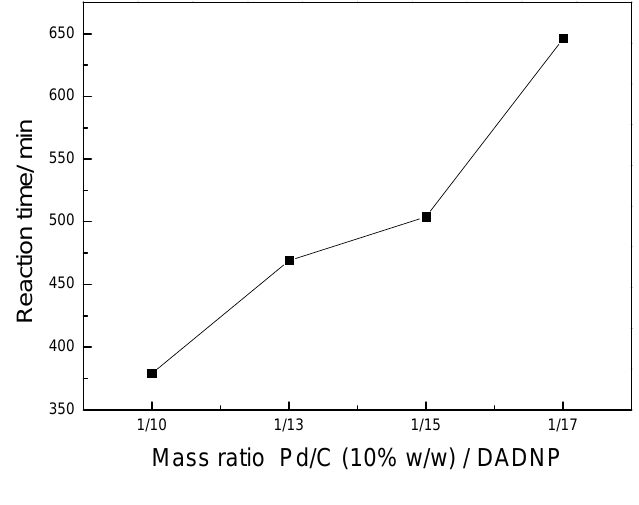
Figure 4. Influence of the mass ratio of Pd/C (10% w/w) and DADNP on the reaction